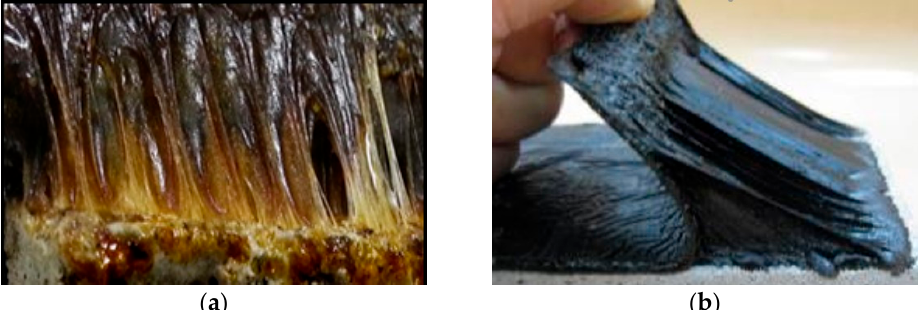
Figure 2. Comparison of adhesion of different NHV-SPRG, ( a ) adhesive type of peeling, ( b ) cohesive type of peeling.